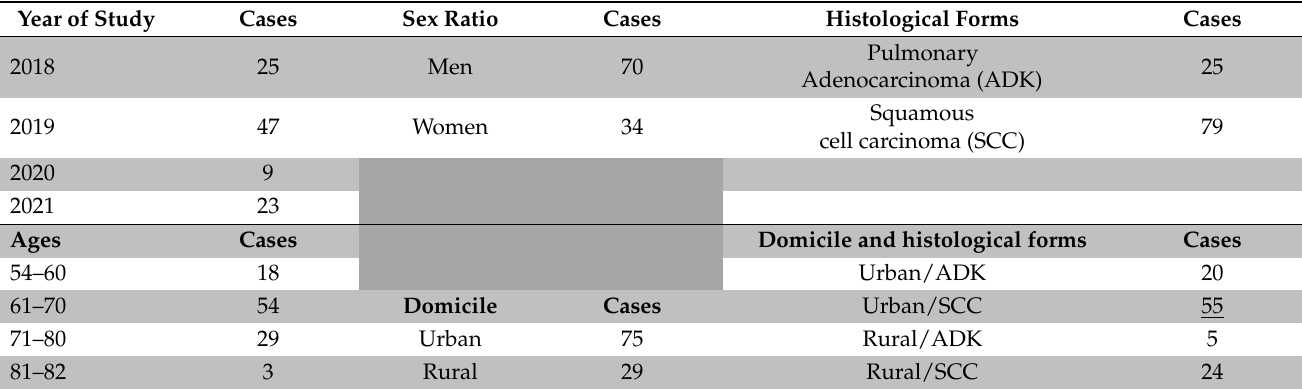
Table 7. The distribution of cases.